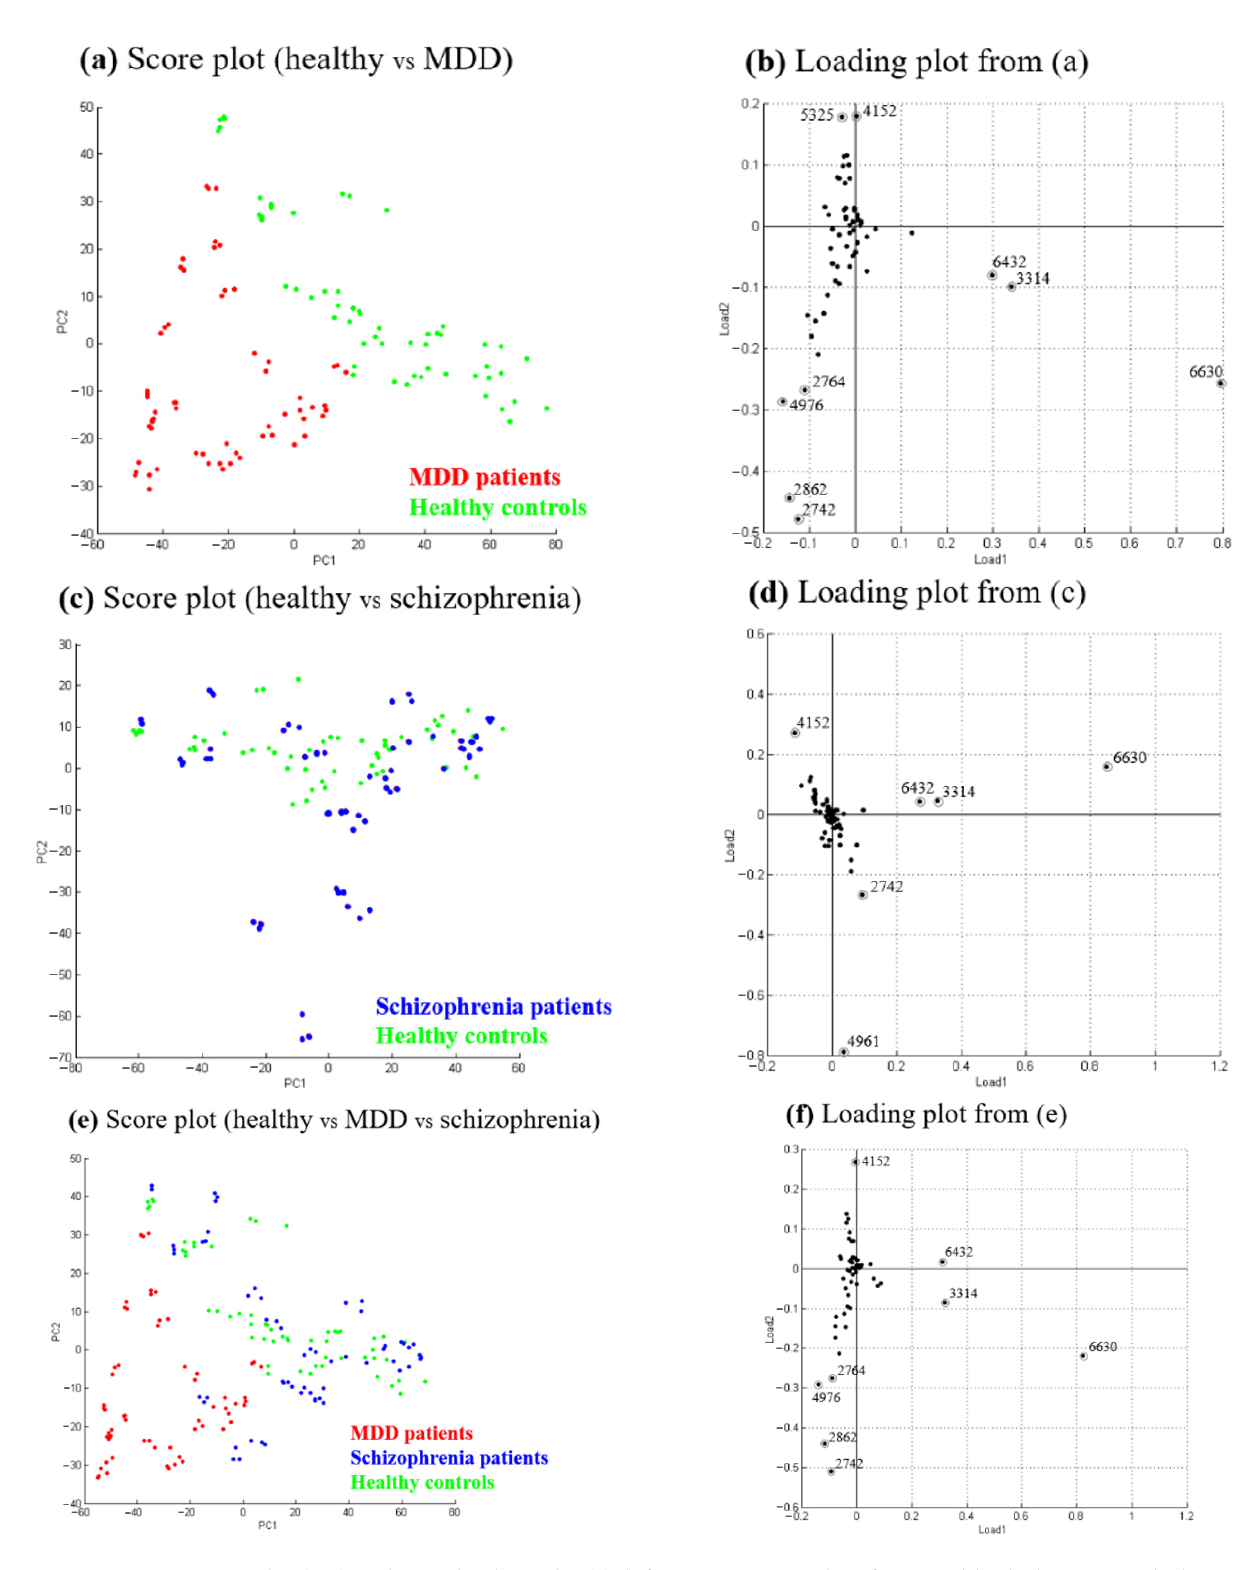
Figure 5. PCA score plot ( a – c ) and PCA loading plot ( d – f ) for MALDI-TOF data from acid hydrolysis-treated plasma samples derived from healthy controls, MDD patients, and schizophrenia patients aged between 19 and 48 years: ( a , b ) healthy controls and MDD patients, ( c , d ) healthy controls and schizophrenia patients, and ( e , f ) healthy controls, MDD patients, and schizophrenia patients.